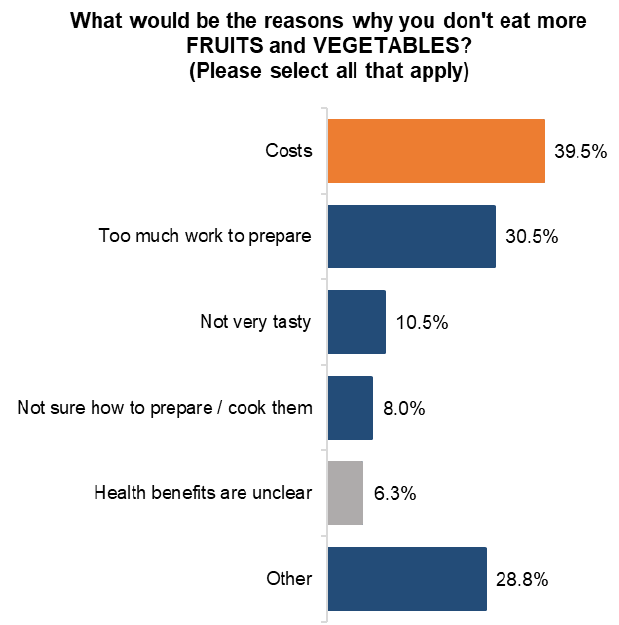
Figure 1. Reasons to buy produce.